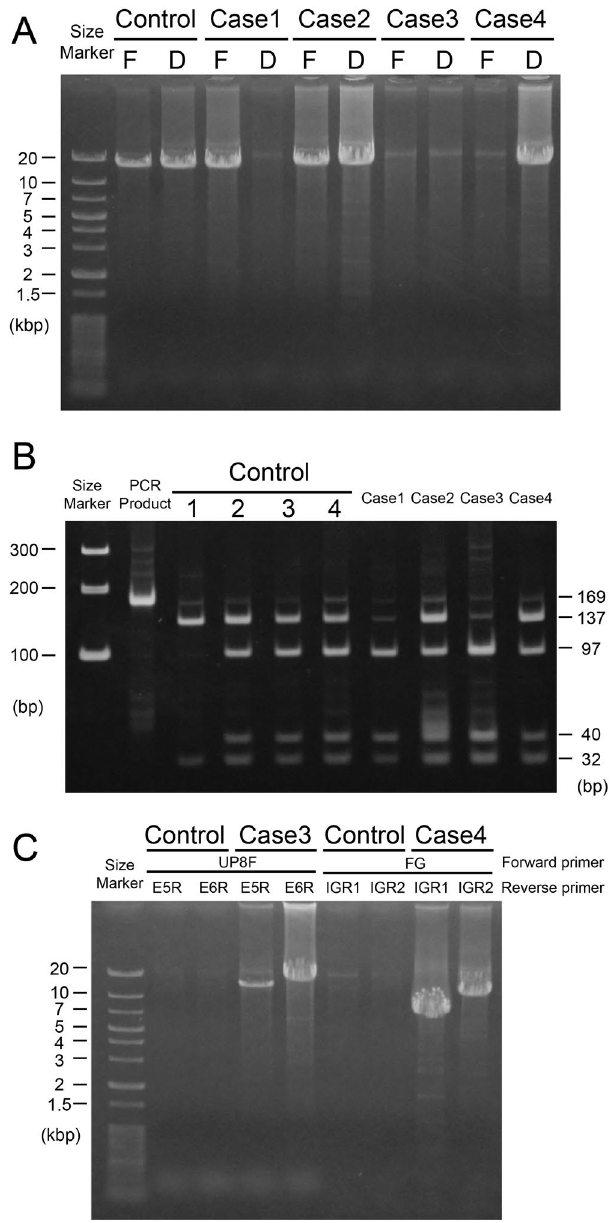
Figure 1. Long-range PCR and promoter analysis. ( A ) First and downstream genes in the L/M gene array were amplified separately by long-range PCR. The control was a color-normal subject having both the first and downstream genes. F, first gene; D, downstream gene(s). Thin bands of approximately 20 kb are not amplified products but the templates (genomic DNA, usually approximately 100 ng per reaction). ( B ) Promoter analysis of gene number. Promoters were amplified by PCR using primers common to the first and downstream genes. PCR products (169 bp) digested with Cfr 10I were loaded onto a polyacrylamide gel. Controls 1–4 have gene numbers 1–4, respectively 28 . ( C ) Long-range PCR beyond the deletion. Combinations of the primers UP8F/E5R and UP8F/E6R were used for long-range PCR in the control and Case 3. Combinations of the primers FG/IGR1 and FG/IGR2 were used for long-range PCR in the control and Case